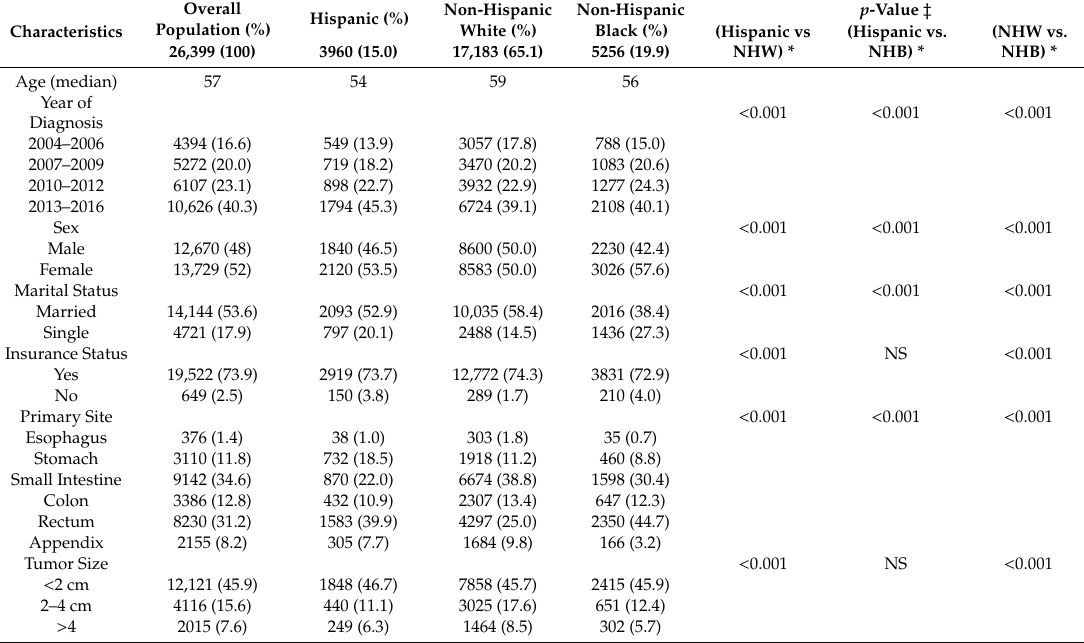
Figure 1. Distribution of gastrointestinal neuroendocrine tumors between race and ethnicity. Table 1. Patient and tumor characteristics by race and ethnicity.